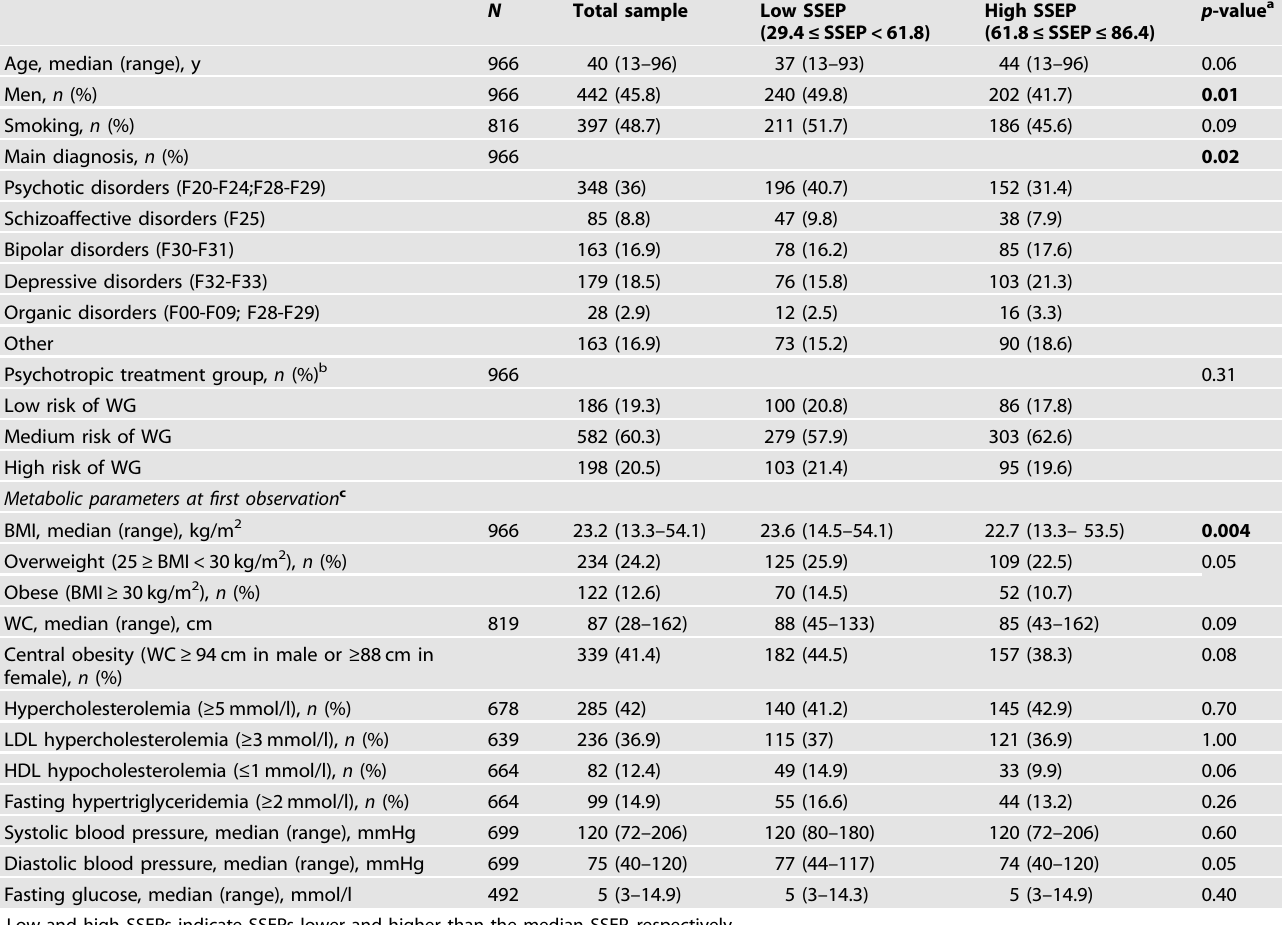
Table 1. Clinical and demographic parameters of the study sample according to SSEP